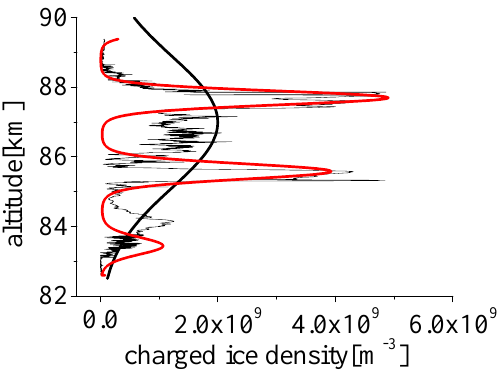
shown in a red line and the undisturbed profile (black thick line) is extrapolated from the ECT02 measuring data (black thin line). Figure 6 also shows that the ion density displays a layered structure under the influence of the Fig. 3. The formation of layer structures with the different ice particle sizes; the size r d = 10nm, 30nm, 50nm, respectively. Fig. 3 The formation of layer structures with the different ice particle size gravity wave, and the variation trend of the space distribution are also well coincided with the experimental data. The size r d =10nm, 30nm, 50nm respectively.